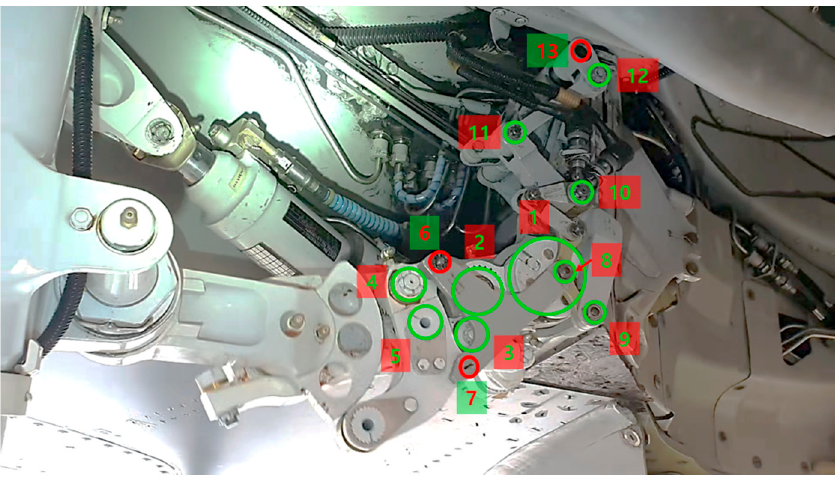
Figure 7. Hawker 800XP aircraft main landing gear joints with clearance [22,23].